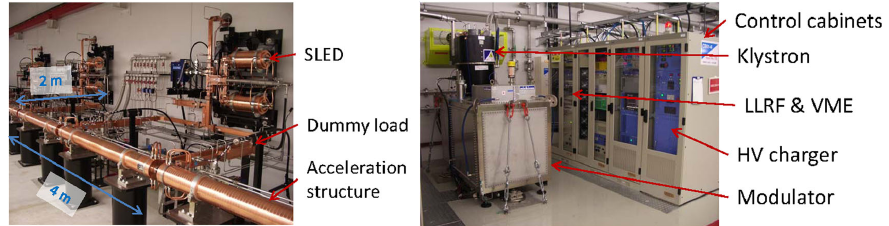
FIG. 3. Photograph inside the accelerator tunnel (left figure) and that of the klystron gallery (right figure) of the SACLA C -band